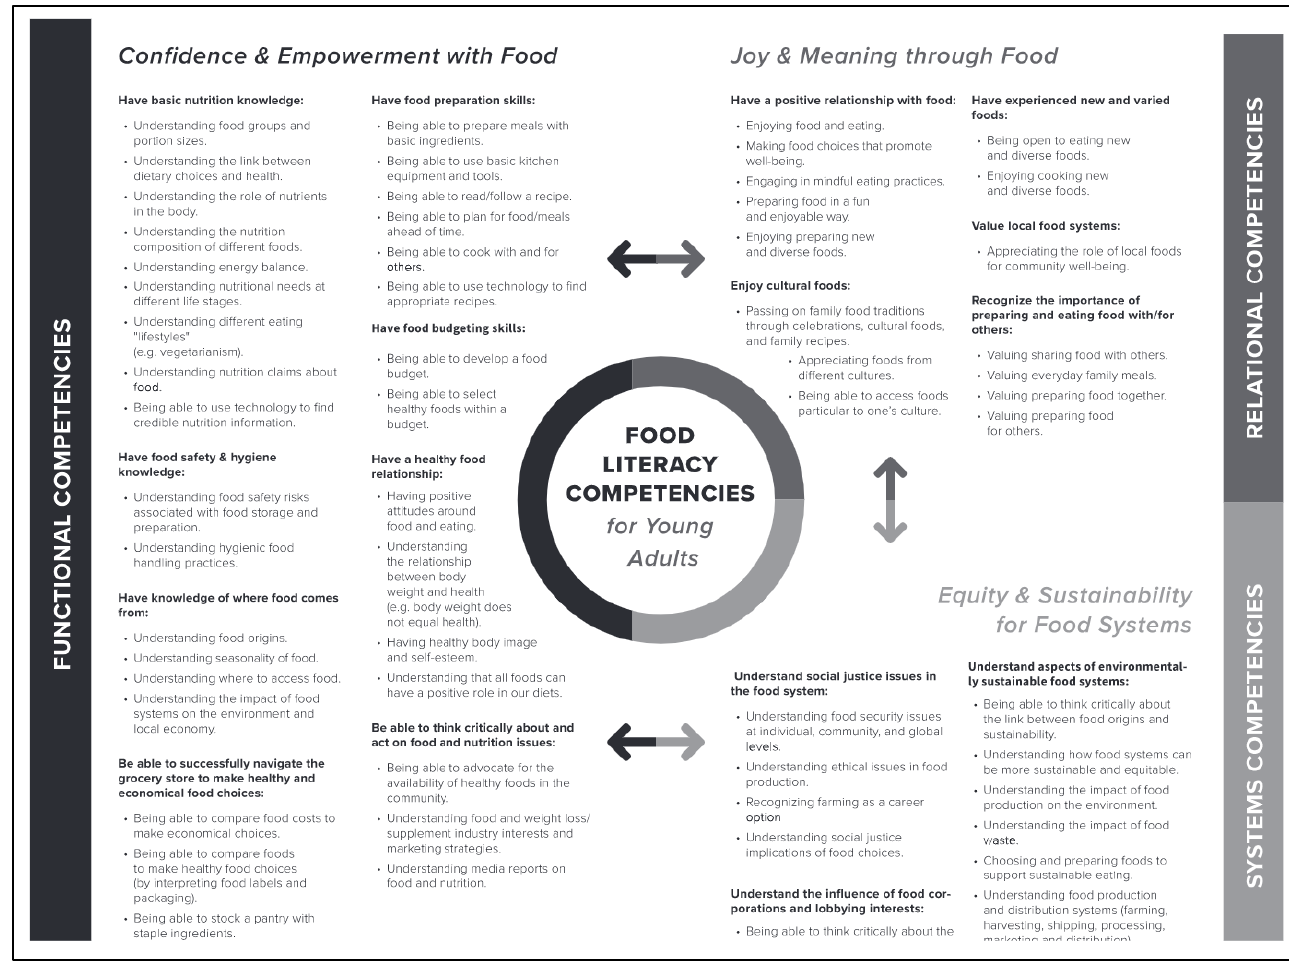
Figure 2. Food Literacy Competencies for young adults grouped by three FL themes [76].